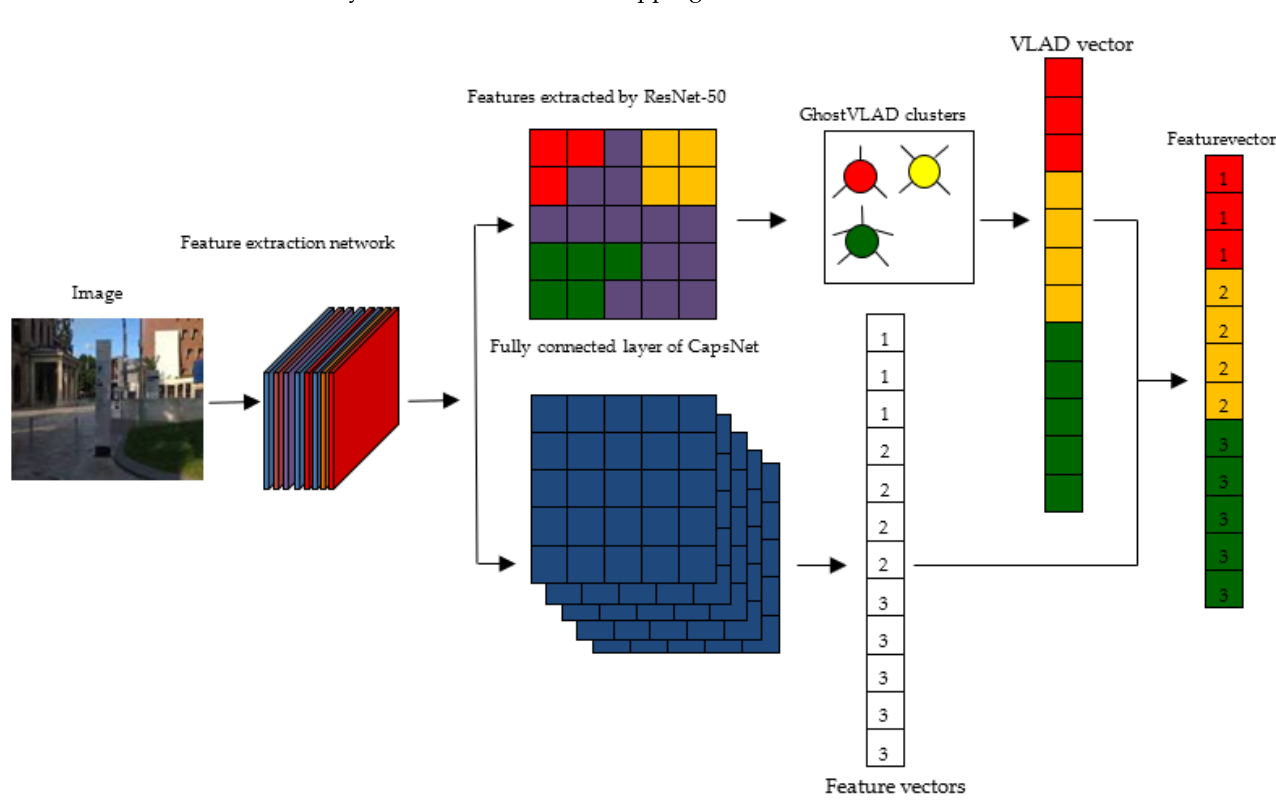
Figure 7. The feature vectors based on the capsule network and the residual network.